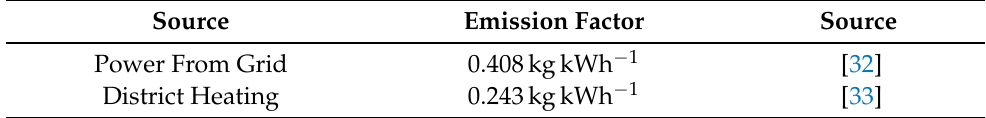
Table 3. Emission factors of power and heat.